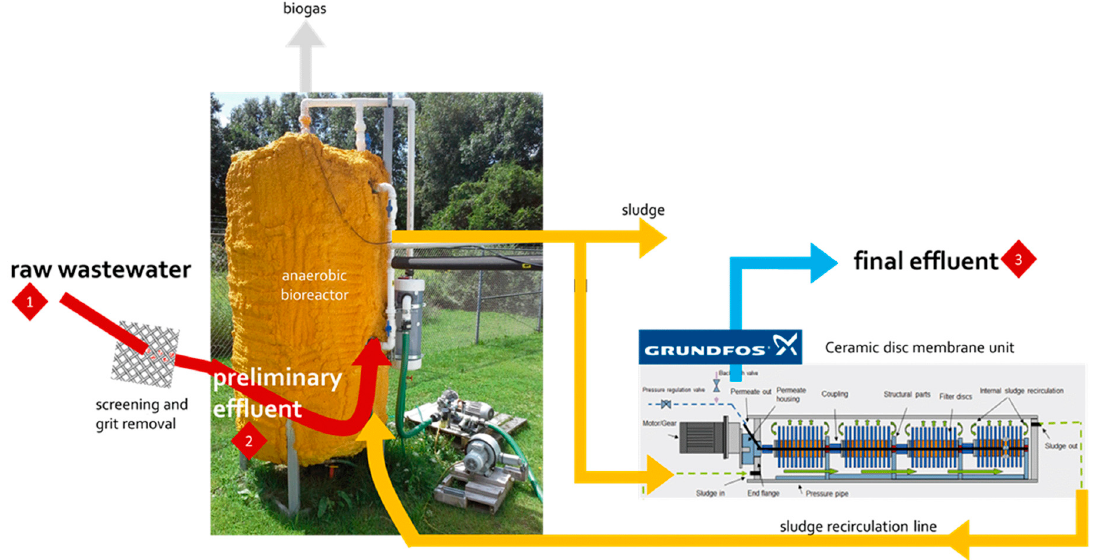
Figure 5. Schematic diagram of a pilot-scale anaerobic membrane bioreactor system equipped with three sampling zones: 1—raw wastewater, 2—preliminary effluent, and 3—final effluent [6].